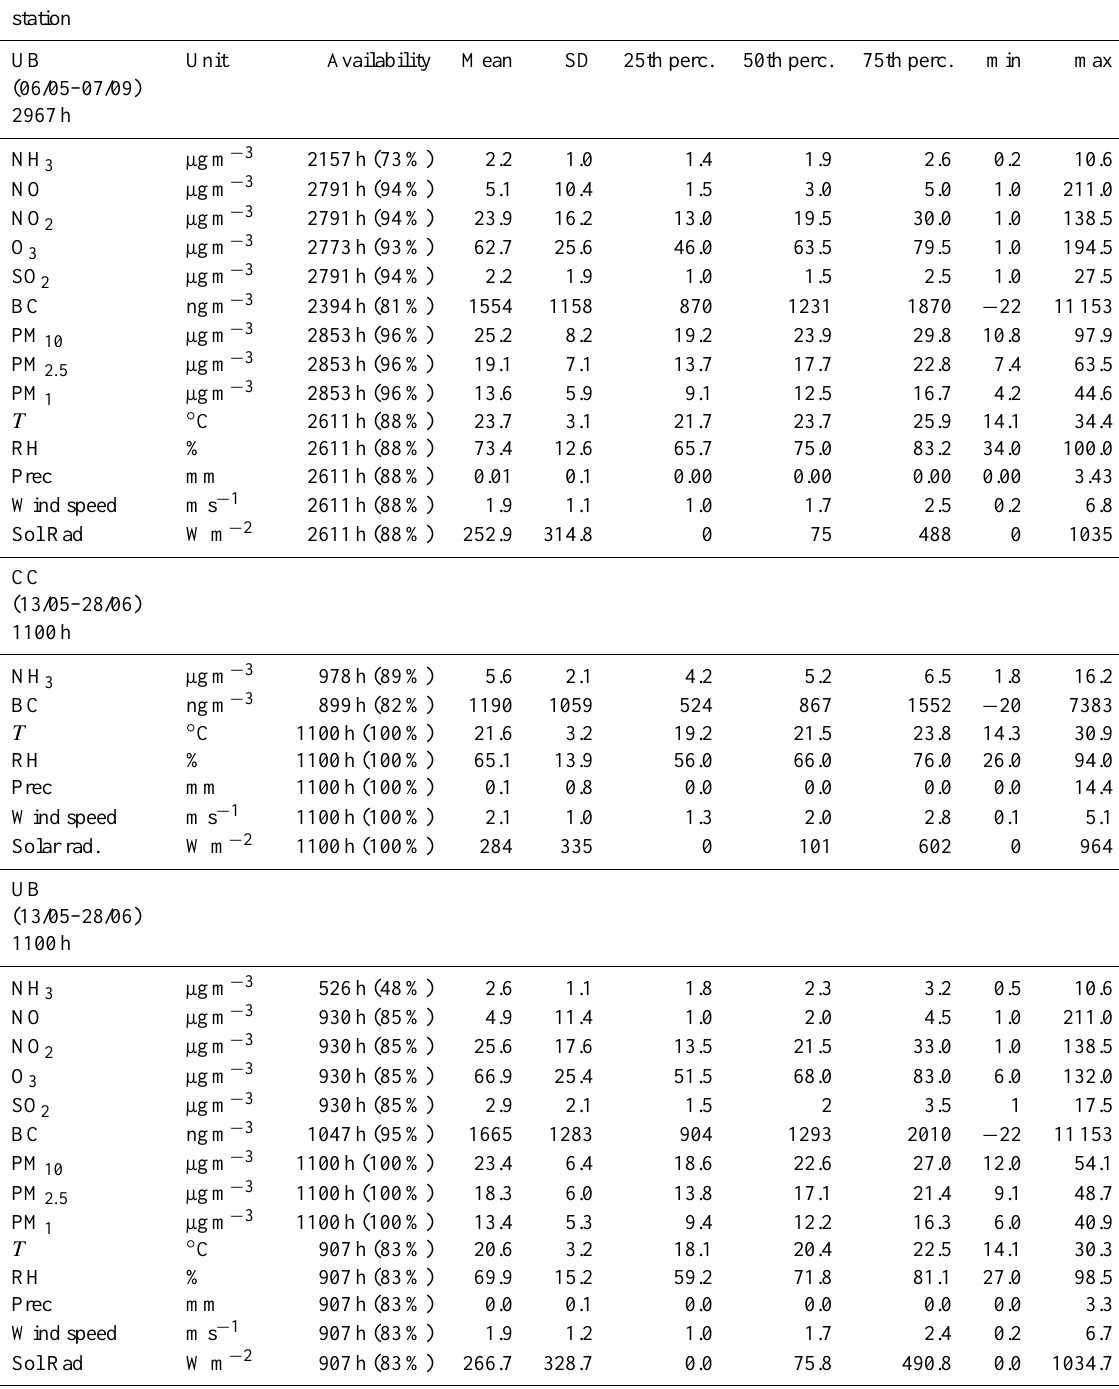
Table 1. Statistics on available measurements performed at the urban background (UB) and historical city centre (CC) measurement stations. Statistics at UB were also reported for the same sampling period of CC station (13 May–28